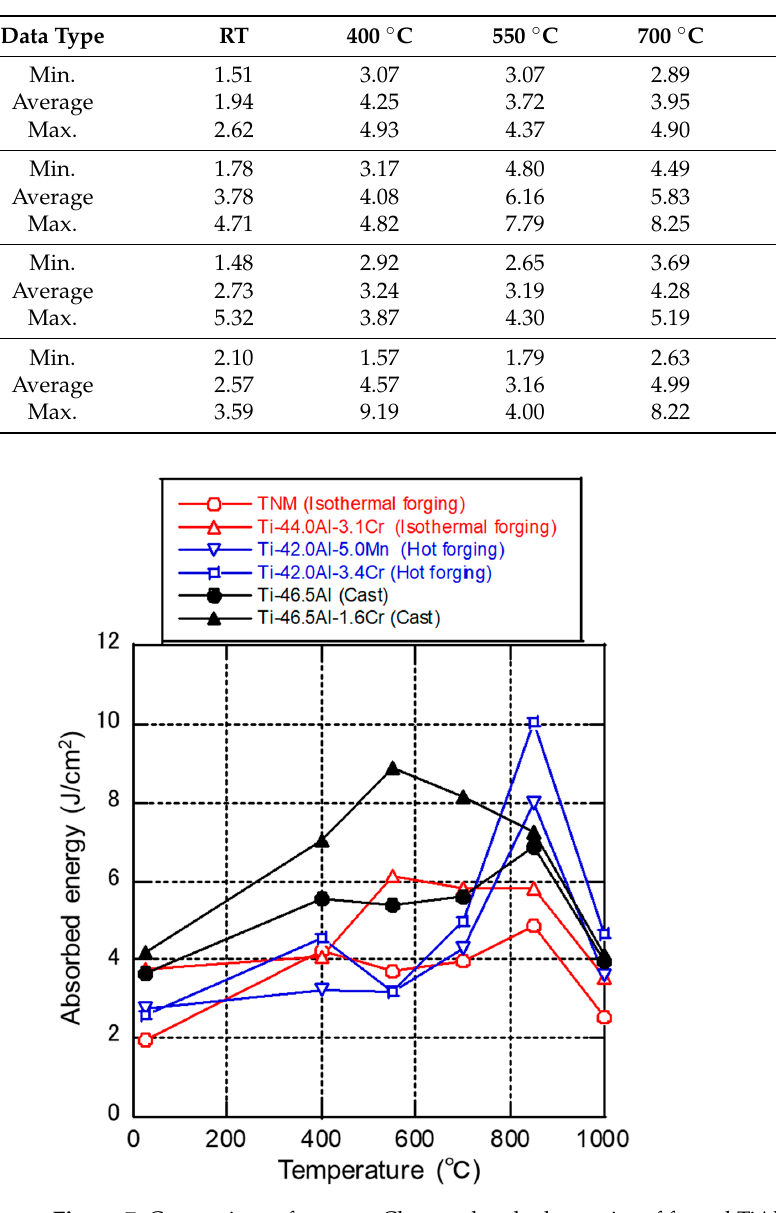
Figure 8. Secondary electron images showing the fractured surfaces of TiAl forged alloys tested by Charpy impact tests at 550 and 1000 °C. The trend in the adsorbed energy at each test temperature is almost the same as those of the cast TiAl alloys. From 400–700 °C, the absorbed energy is two- to three-times higher than that at room temperature, but at 1000 °C, it drops sharply. The reason for this is the temperature-induced changes in tensile strength and ductility, as in the case of the cast TiAl alloys. On the other hand, only two hot-forged alloys showed a significant increase in absorbed energy at 850 °C. The reason for this is thought to be that the effect of the β